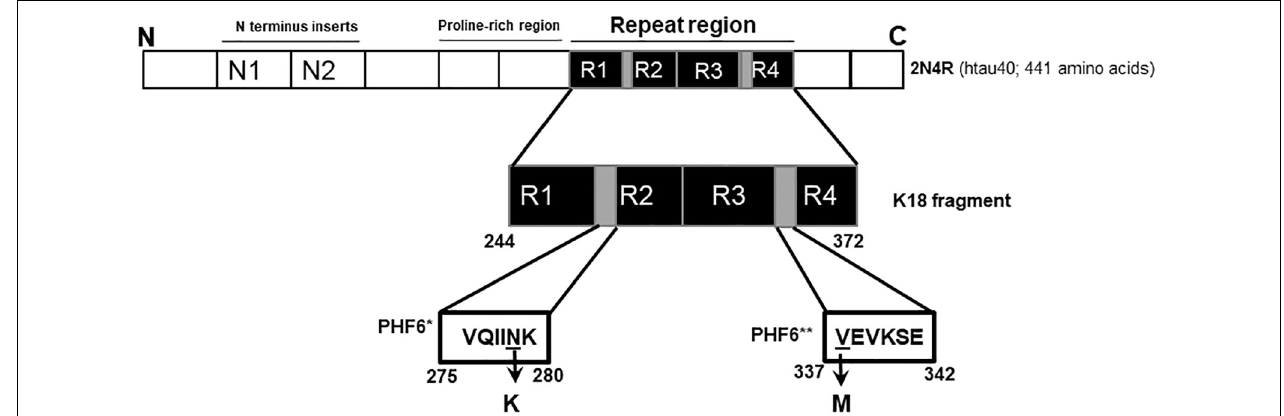
FIGURE 1 | Schematic illustration of the N279K and V337M mutations in tau. The K18 fragment used in this study was constructed based on the full-length human brain tau isoform (2N4R; htau40). The N279K mutation is located in the alternatively spliced second repeat region (R2), specifically within the hexapeptide motif at the start of R2 (PHF6 ∗ ; gray). The V337M mutation can be found at the start of the fourth repeat domain, and falls within the third hexapeptide motif (PHF6 ∗∗ ; second gray